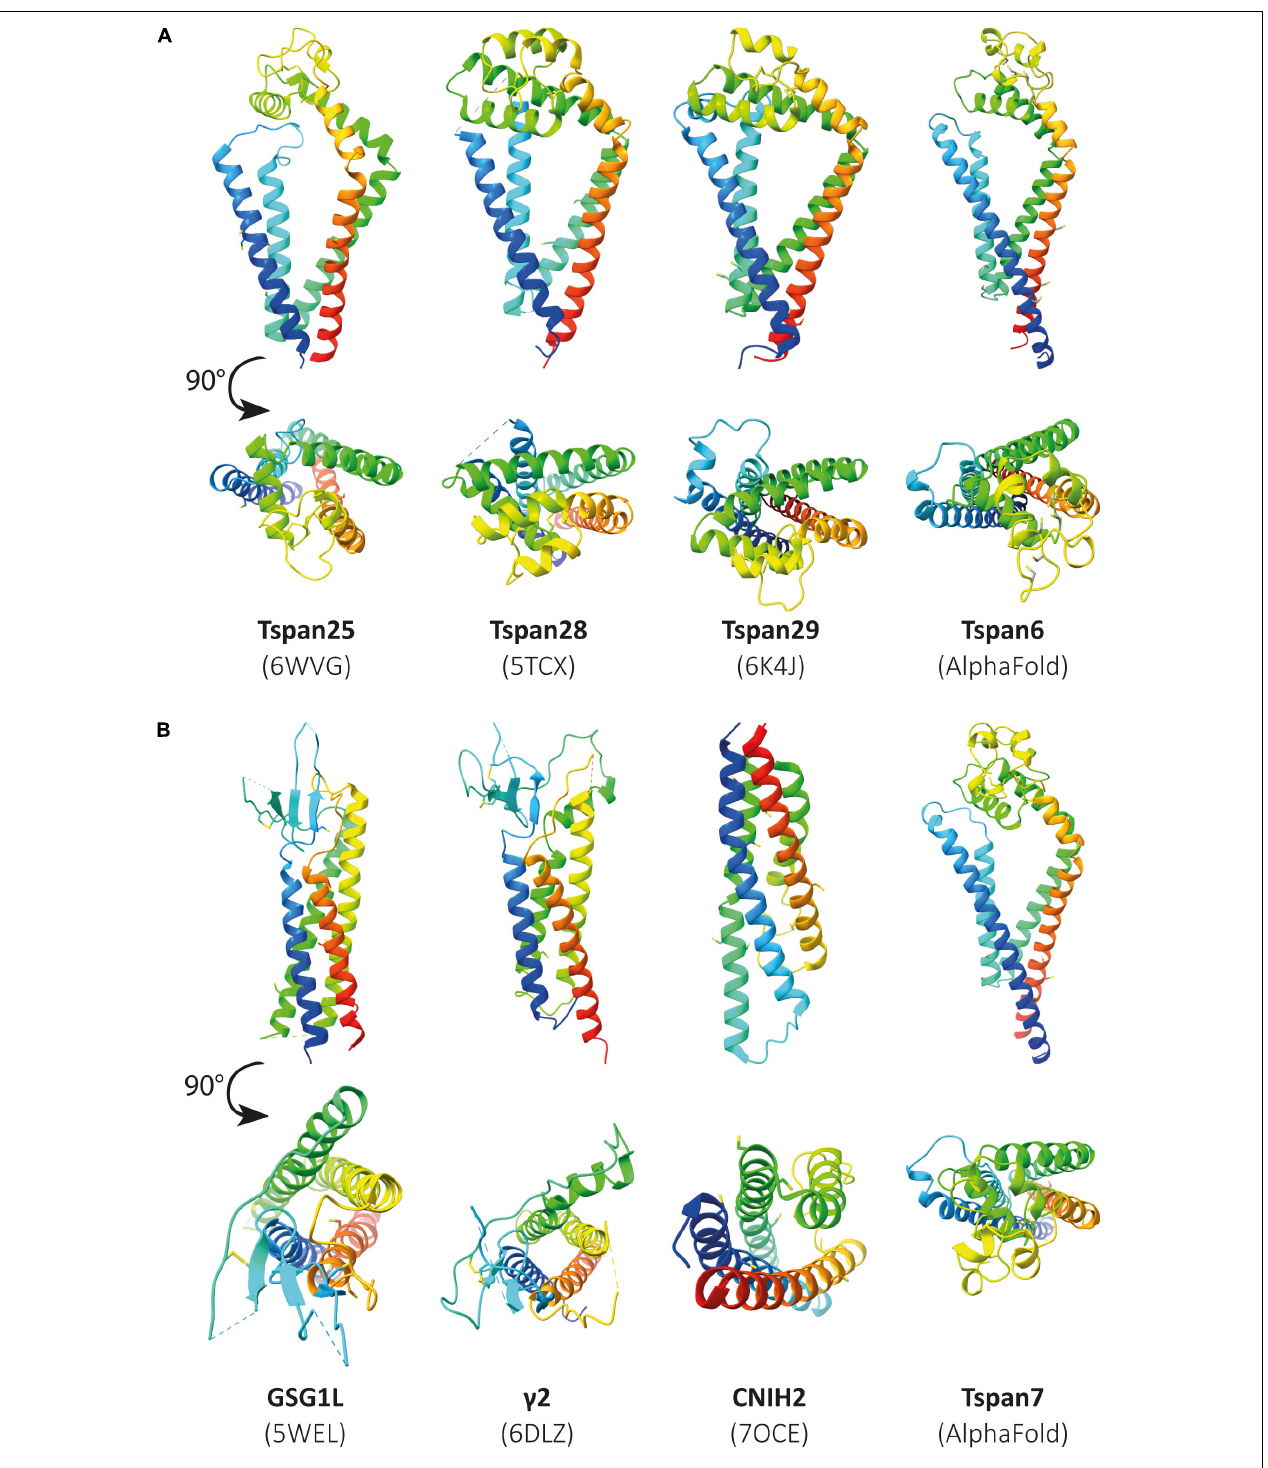
FIGURE 6 | Illustration of previously resolved and predicted tetraspanin structures in comparison to resolved structures of known AMPAR auxiliary subunits. Ribbon diagrams rainbow-colored (from N-terminus in blue to C-terminus in red) showing the structures of the chosen proteins from Homo sapiens , displayed with different views, one parallel to the membrane (upper) and another from the extracellular side rotated by a 90 ◦ angle (lower). In panel (A) the following structures are depicted (from left to right): Tspan25 (pdb model 6WVG), Tspan28 (pdb model 5TCX), Tspan29 (pdb model 6K4J), and Tspan6 (AlphaFold database). Panel (B) shows the structures of GSG1L (pdb model 5WEL), γ 2 (pdb model 6DLZ), CNIH2 (pdb model 7OCE), and Tspan7 (AlphaFold database) from left to right.